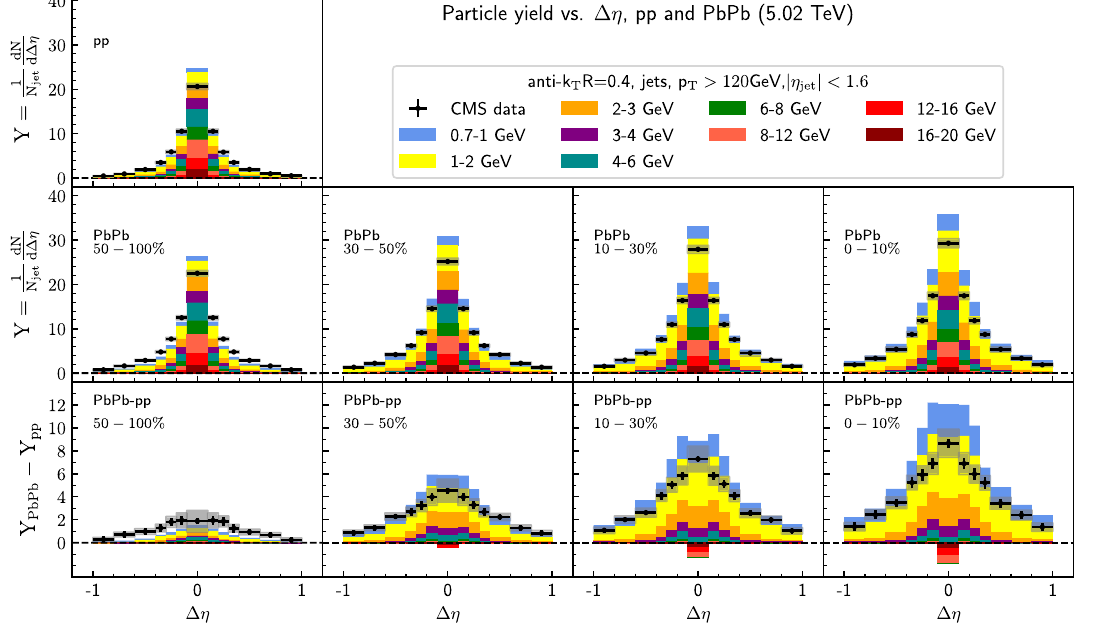
Fig. 4 Jet-correlated charged particle yield distribution as a function histograms are obtained from the AMPT model: different colors repre- of (cid:2)η in p + p (top left panel), Pb + Pb (middle panels) collisions and sent the contributions from different p T intervals for charged particles. their differences (lower panels). Four different Pb + Pb collision cen- The accumulated histogram for 0 . 7 < p T < 20 GeV is compared to tralities are shown: 0 − 10% , 10 − 30% , 30 − 50%, and 50 − 100%. Jets CMS data > 120 GeV, R = 0 . 4 and | η | < 1 . 6. The stacked are taken with p jet jet T